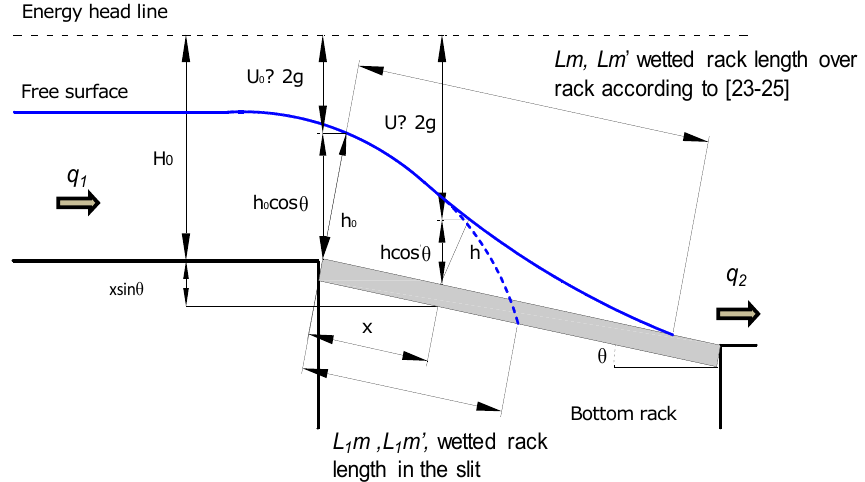
Figure 5. Scheme of the spatially varied flow over the bottom intake system.